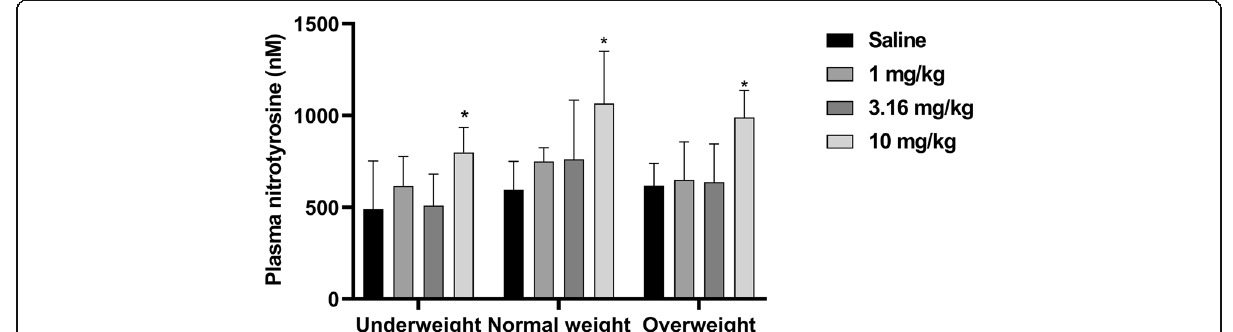
Fig. 2 Dose-dependent effects of LPS on plasma concentrations of nitrotyrosine (nM) 15 to 20 h after the injection of LPS (treatment groups A through D). Data are expressed as the mean ± SD; n = 4. * P < 0.05 compared with that of the aorta from rats treated with saline (treatment groups A and D)